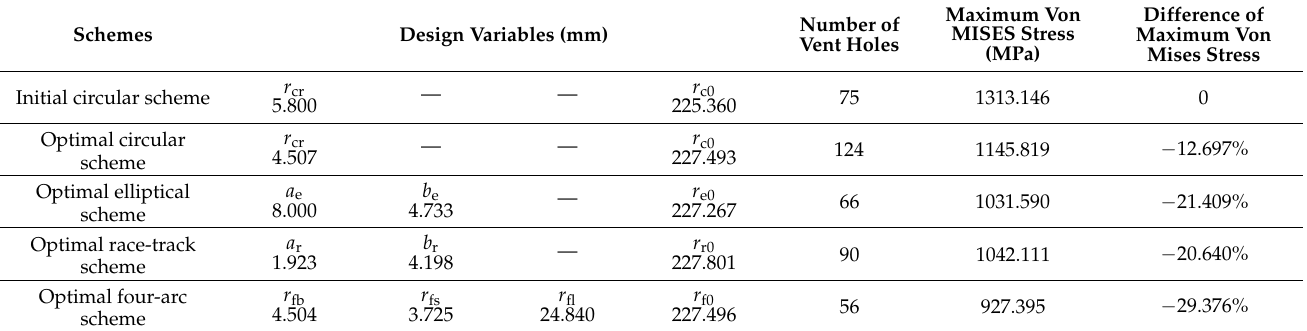
Table 4. Details of the initial circular scheme, optimal circular scheme, optimal elliptical scheme, optimal race-track scheme, and optimal four-arc